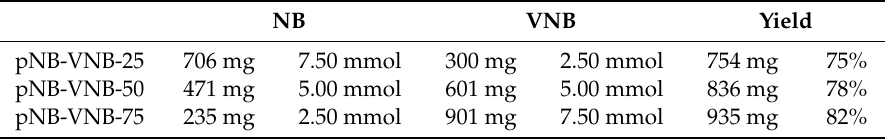
Table 1. Polymerization parameters for the copolymers using NB and